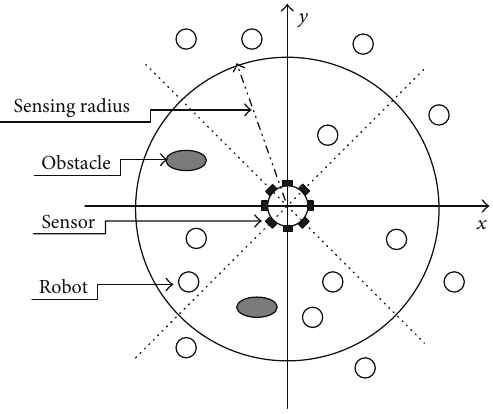
Figure 1: The state model of